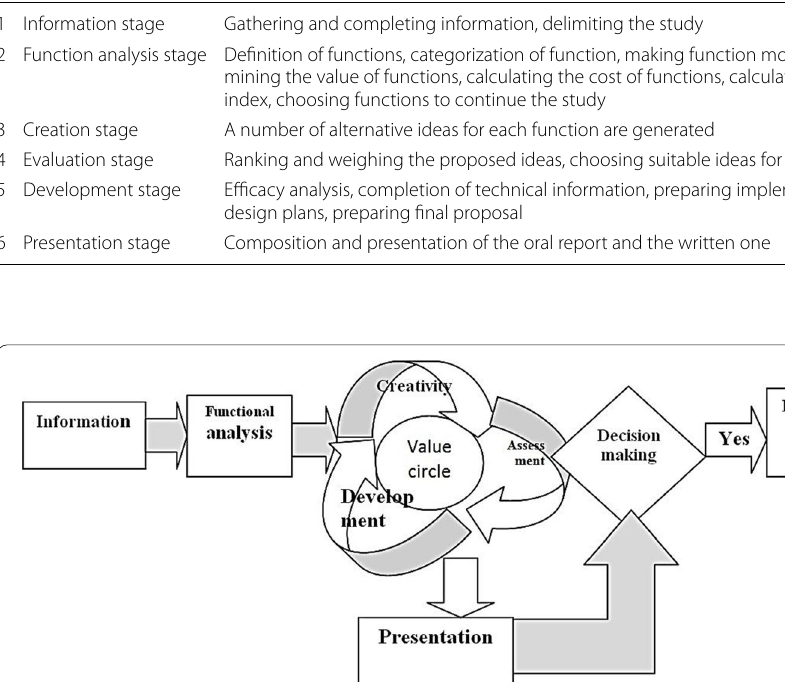
Table 2 Value engineering methodologies